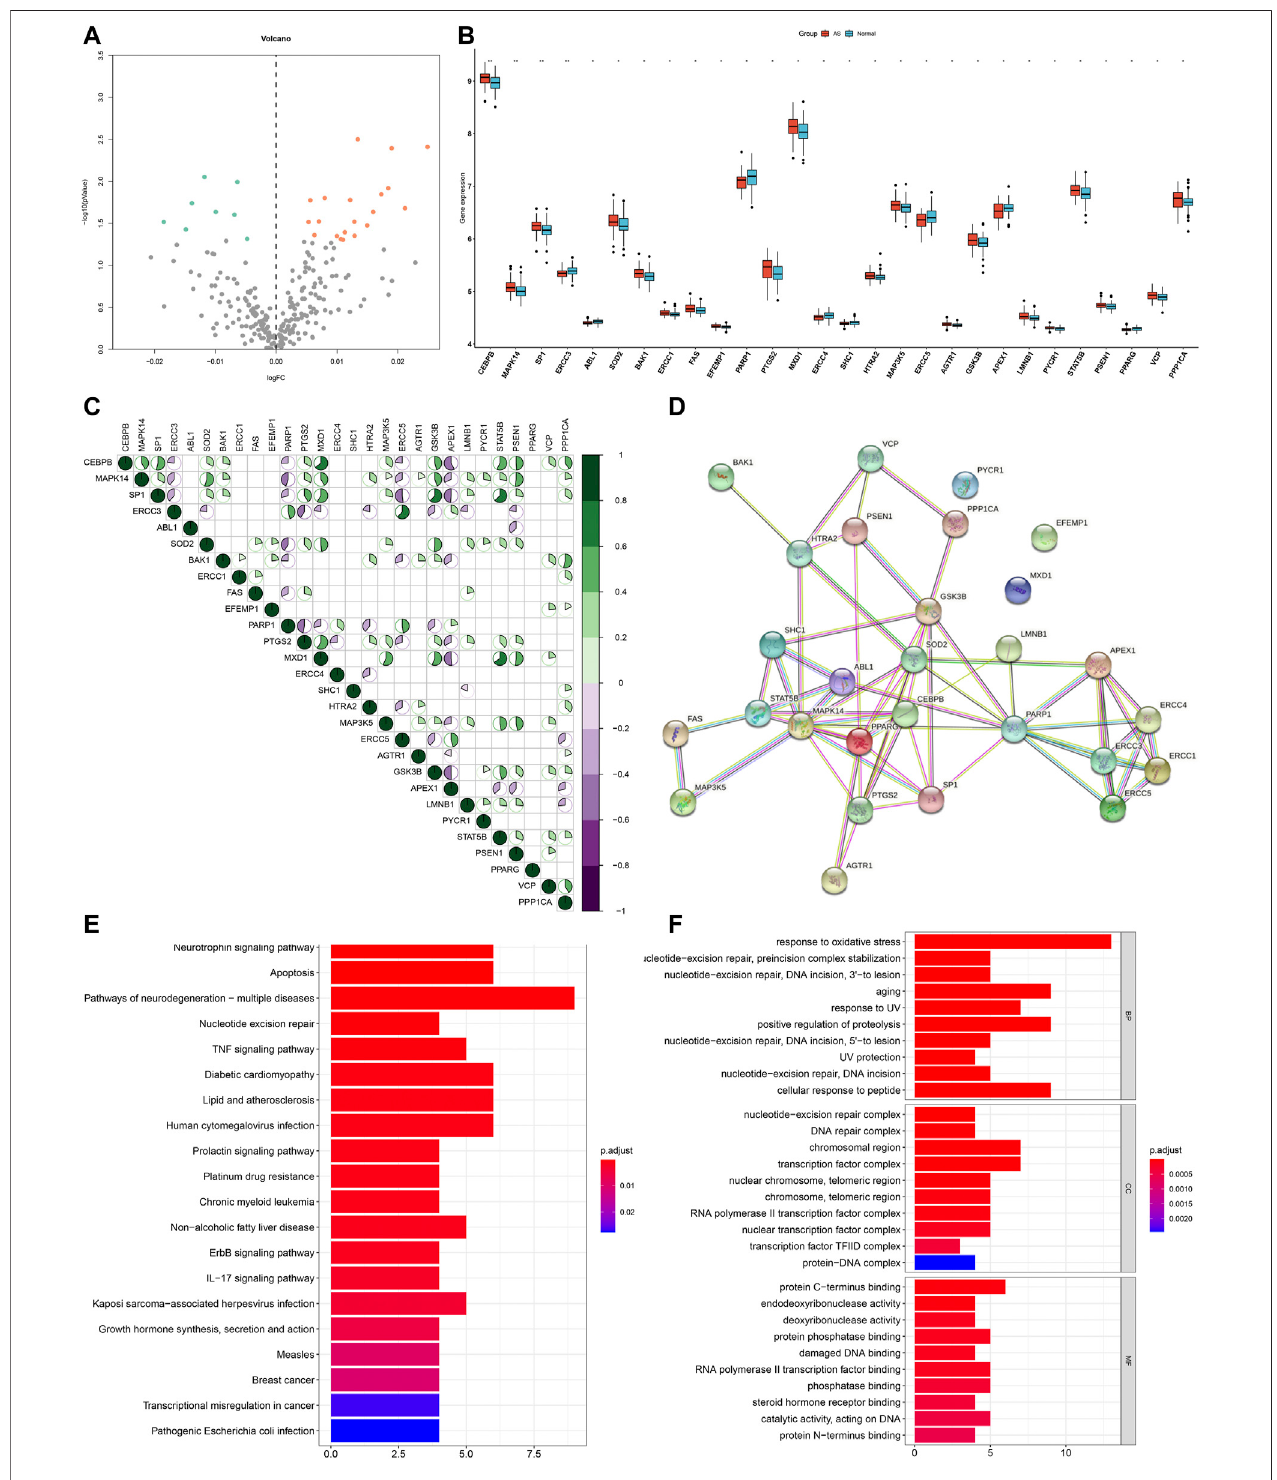
FIGURE 1 | Expression patterns and biological signi fi cance of aging-related genes in AS. (A) Volcano plots visualizing the expression patterns of aging-related genes in AS and non-AS samples. Orange bubbles mean up-regulated genes, blue bubbles mean down-regulated genes, and gray bubbles mean non-signi fi cant genes. (B) Box plots showing the differentially expressed aging-related genes in AS and non-AS samples. * p < 0.05; ** p < 0.01. (C) Pearson correlation between AS- speci fi c aging-related genes among AS samples. Purple represents negative correlation, while green represents positive correlation. (D) PPI network of proteins encodedbyAS-speci fi caging-related genesthrough theSTRINGdatabase. (E) KEGG pathways enriched byAS-speci fi caging-related genes. (F) Biologicalprocesses (BPs), cellular components (CCs), and molecular functions (MFs) associated with AS-speci fi c aging-related genes.